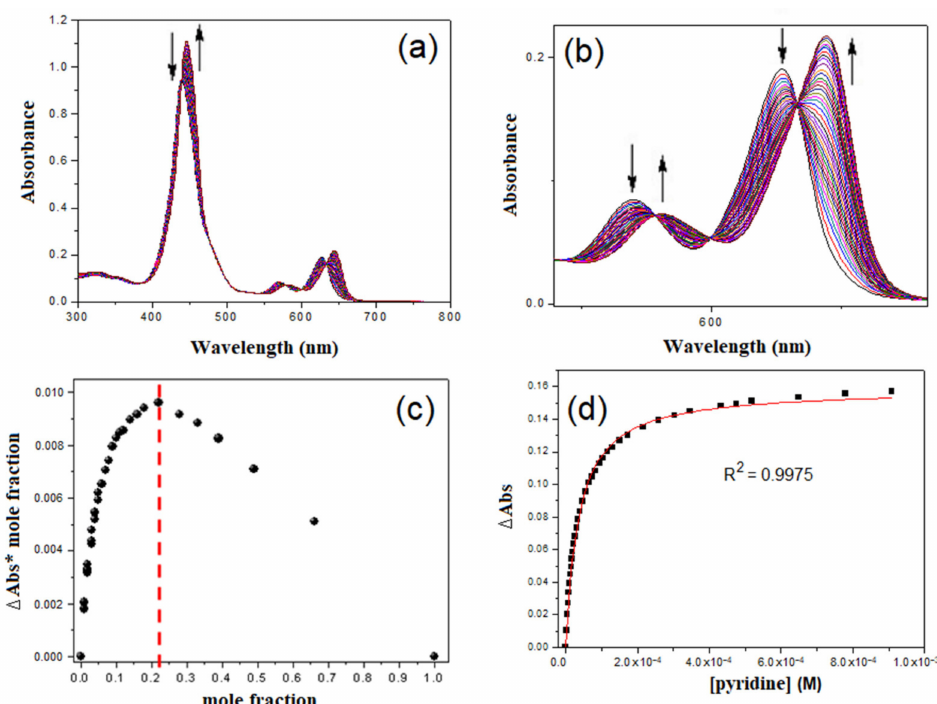
Figure 1. UV-vis titration spectra of Zn-trisporphyrin 1 complexation with pyridine in toluene ( c = 1 µ M). ( a ) UV-visible region, ( b ) Q-band zone, ( c ) data curve for Job’s plot at 446 nm (mole fraction of 1 ), ( d ) fitting curve for the determination of the binding constant K 31 at 446